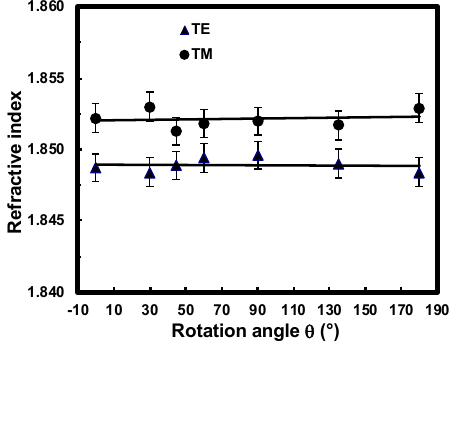
Figure 6. Measured refractive indices as a function of the rotation angle for TE and TM polarizations for the undoped 7-layer ZnO thin